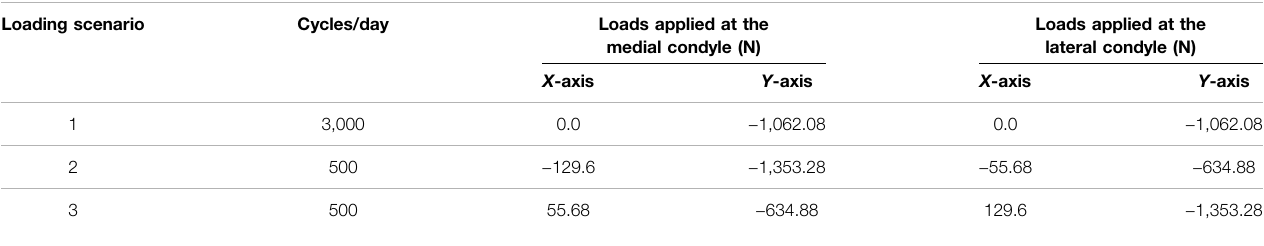
TABLE 2 | Values of the forces applied on each condyle (Perez et al., 2010; Quilez et al., 2017). Loading scenario Cycles/day Loads applied at the Loads applied at the medial condyle (N) lateral condyle (N) X -axis Y -axis X -axis Y -axis 1 3,000 0.0 − 1,062.08 0.0 − 1,062.08 500 − 129.6 − 1,353.28 − 55.68 − 634.88 500 55.68 − 634.88 129.6 −